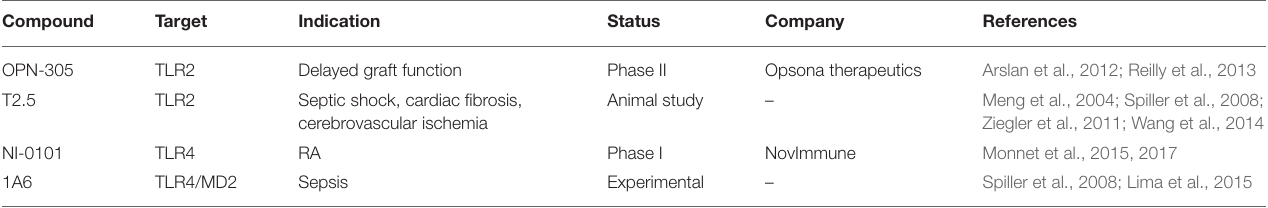
RA, rheumatoid arthritis.